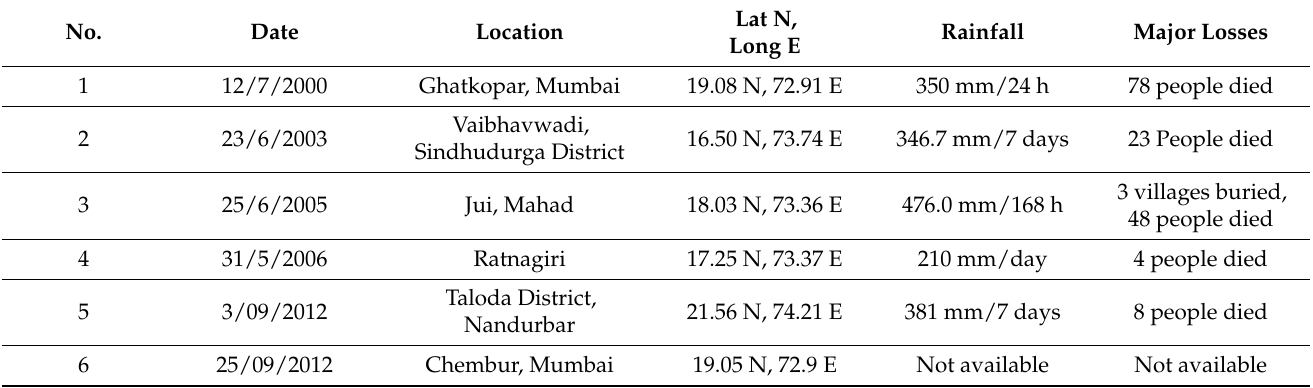
Table 7. Rainfall-triggered landslides over the WG region from 2000 to 2016. Date (date/month/year), location, latitude/longitude of the LS location, rainfall, and major